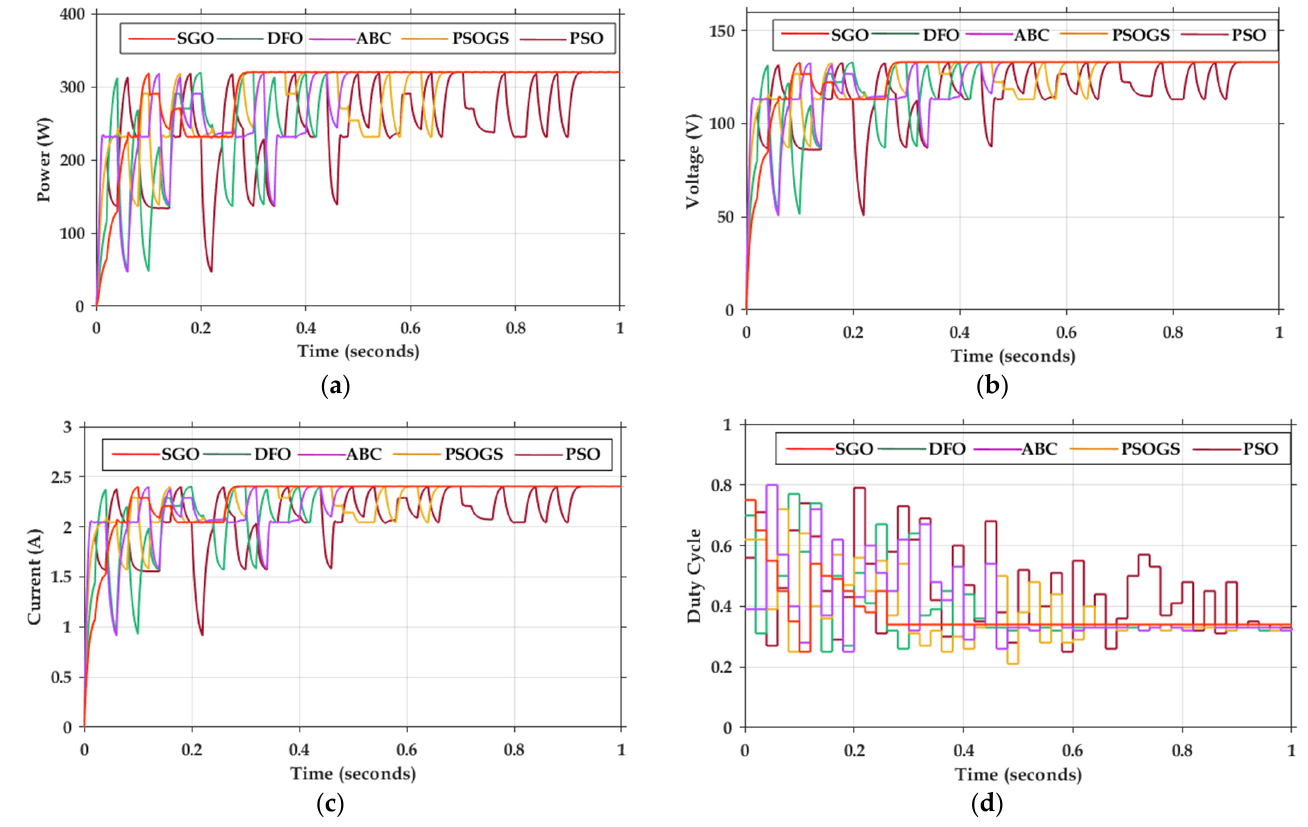
( d ) Figure 10. Case 2: comparison of ( a ) power, ( b ) voltage, ( c ) current, ( d ) duty cycle of SGO, DFO, ABC, PSOGS, and PSO. 4.2.3. Case 3 In the last scenario, the magnitude of the shading on each panel was increased, and the pattern was 800, 300, 700, and 550 W/m 2 , respectively. The expected GMPP was 322.2W. The details concerning the mixed irradiance profile are available in Table 3. The